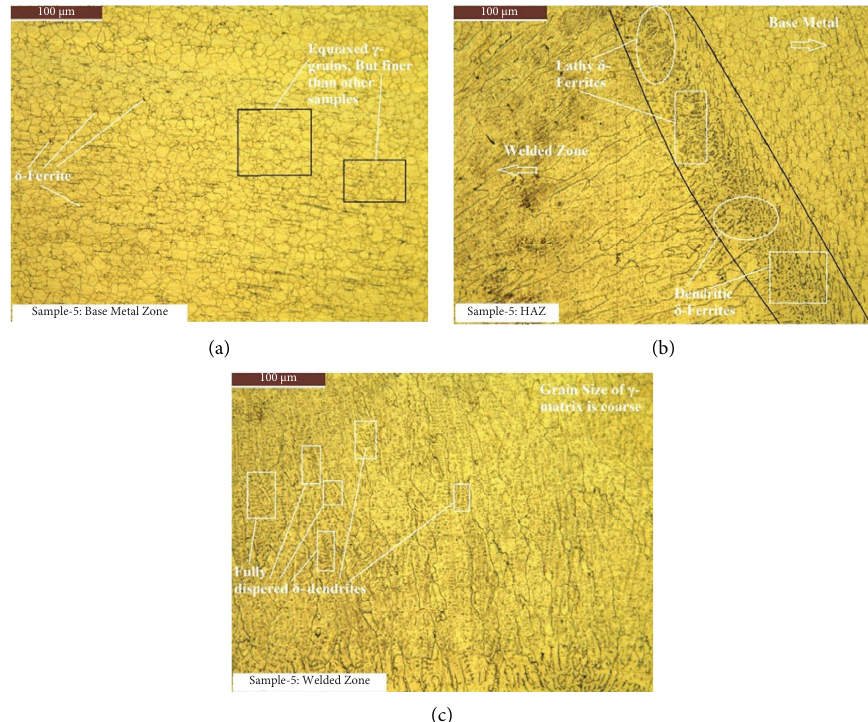
Figure 9: Microstructural appearance of sample 5, stepped cooled (sand +water-cooled): (a) the base metal, (b) HAZ, and (c) welded